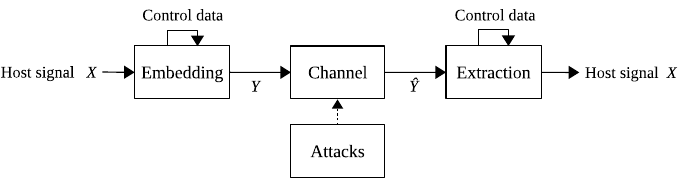
Figure 3. General self-recovery